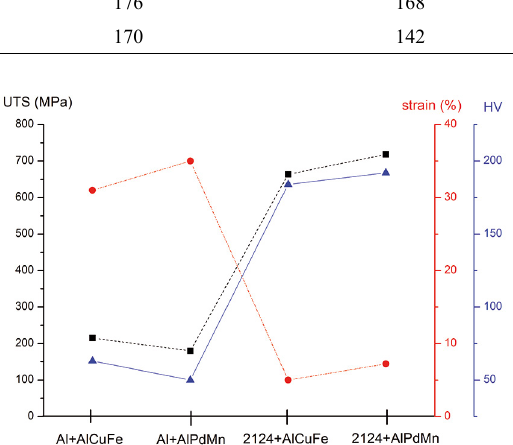
Figure 6: Mechanical properties obtained for the composites. Squares: equivalent ultimate tensile strength; triangles: Vickers hardness; circles: equivalent deformation at